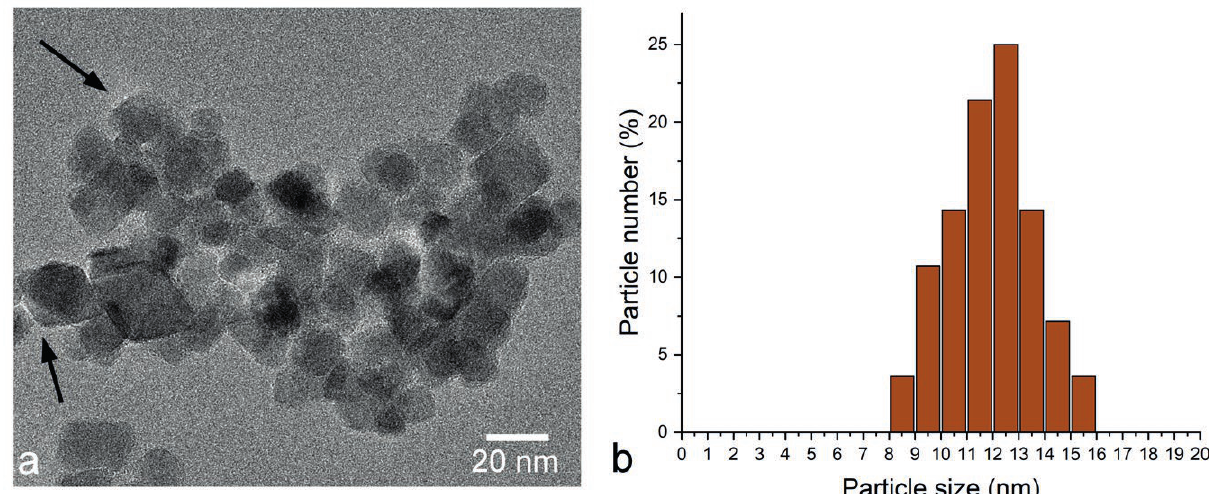
Figure 1. A representative transmission electron micrograph of the composite magnetic nanoparticles (a) and the corresponding particle size histogram (b). Arrows in (a) denote the bright regions on the particle surface originating from the carbon coating that protects the par- ticles against